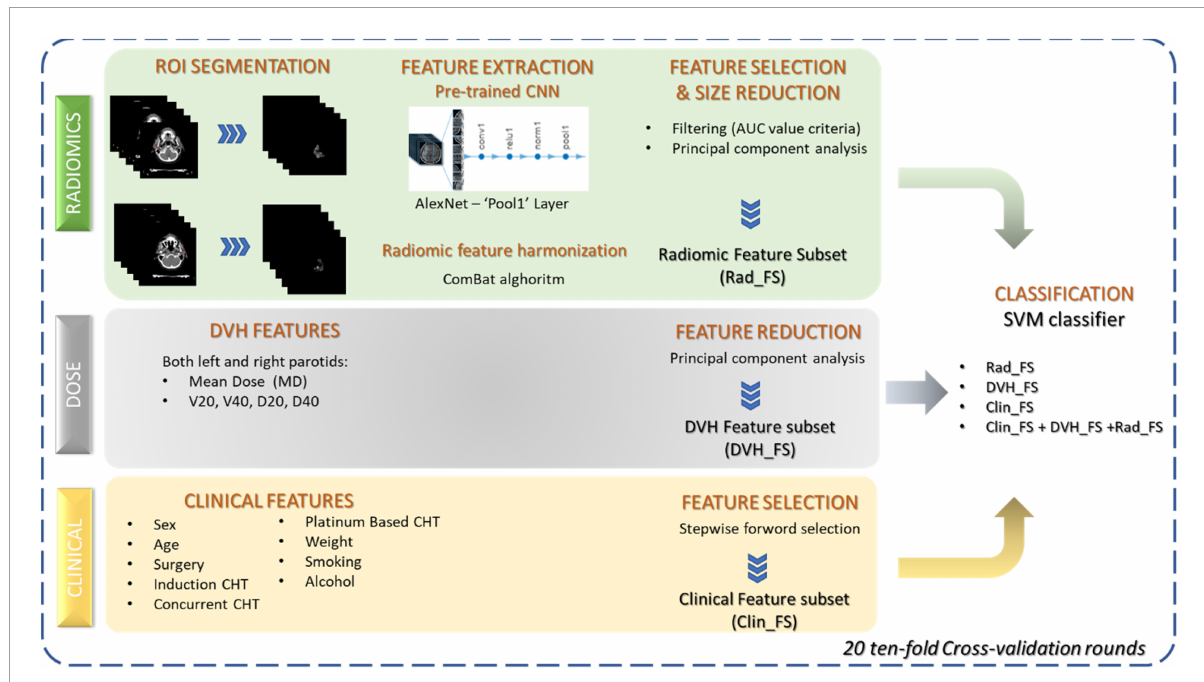
FIGURE2 Workflow of the proposed classification approach. Three sets of features were considered: radiomic features extracted from parotid images by means of a pre-trained CNN, dose features extracted from DVH, and clinical features before RT beginning. Feature reduction and selection techniques were applied to the three sets of features to identify three subsets of significant features. SVM classifier was trained both on the individual feature subsets and using all the feature kinds